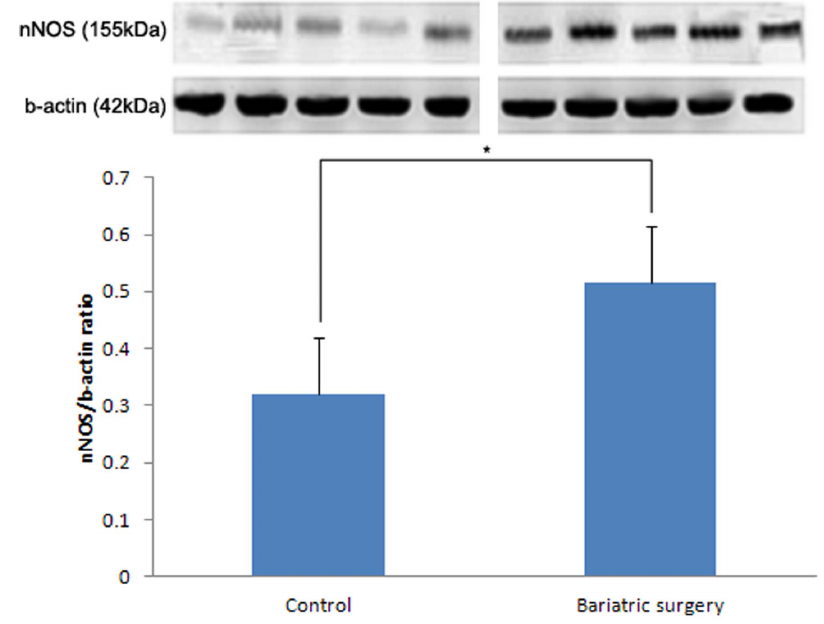
Figure 6. nNos/b-actin ratio in the control and bariatric surgery groups (*: p=0.008).